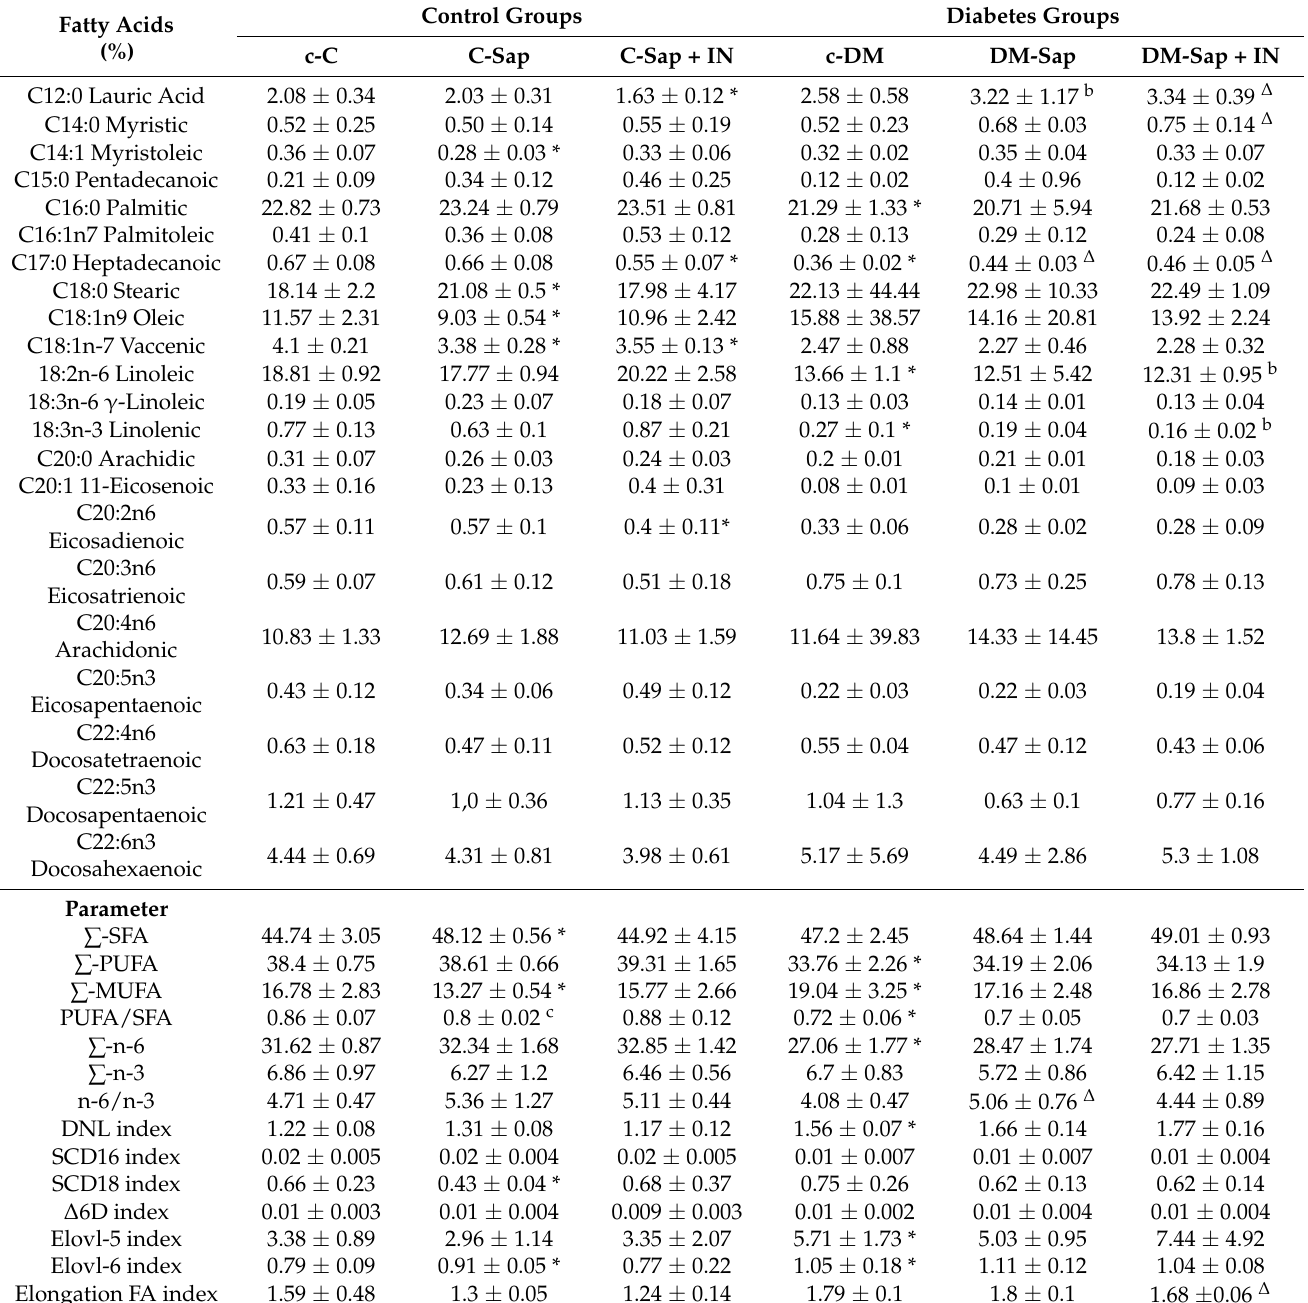
Table 3. Liver fatty acid profiles in each subgroup of